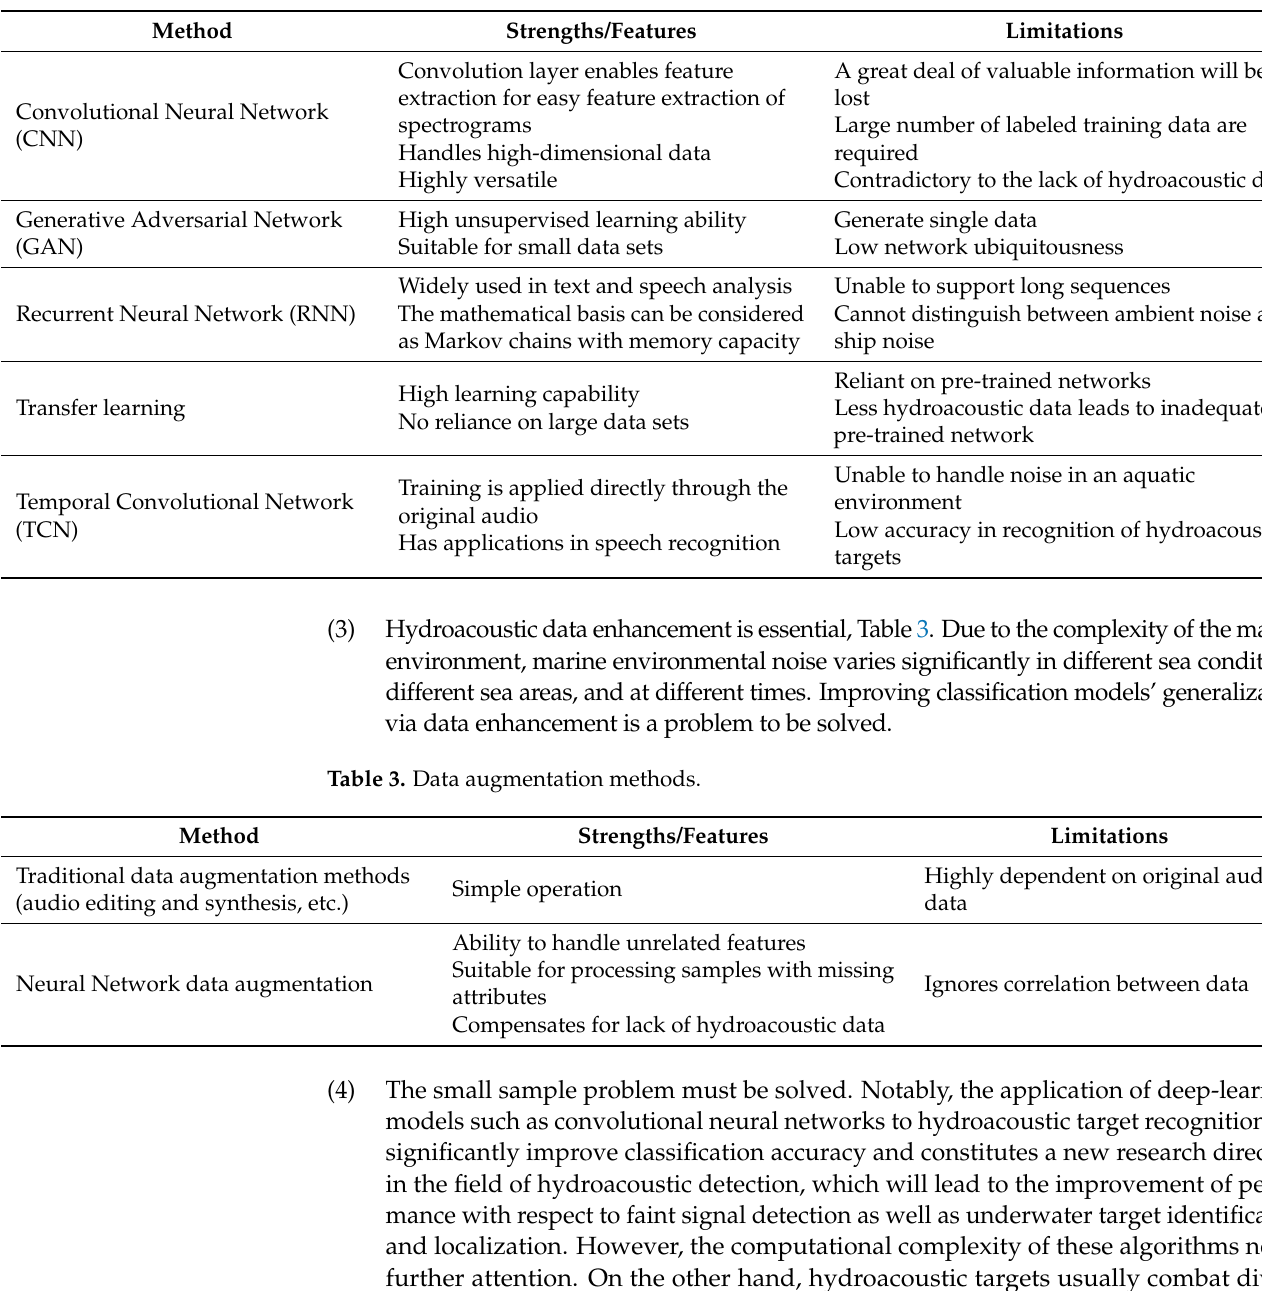
Table 2. Deep-learning methods.